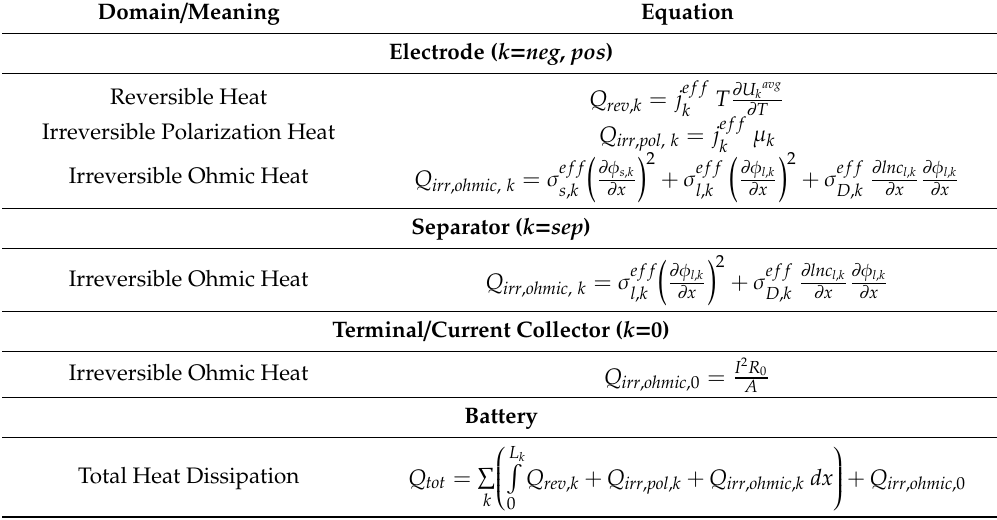
Table 2. The heat dissipation sources within the physico-chemical